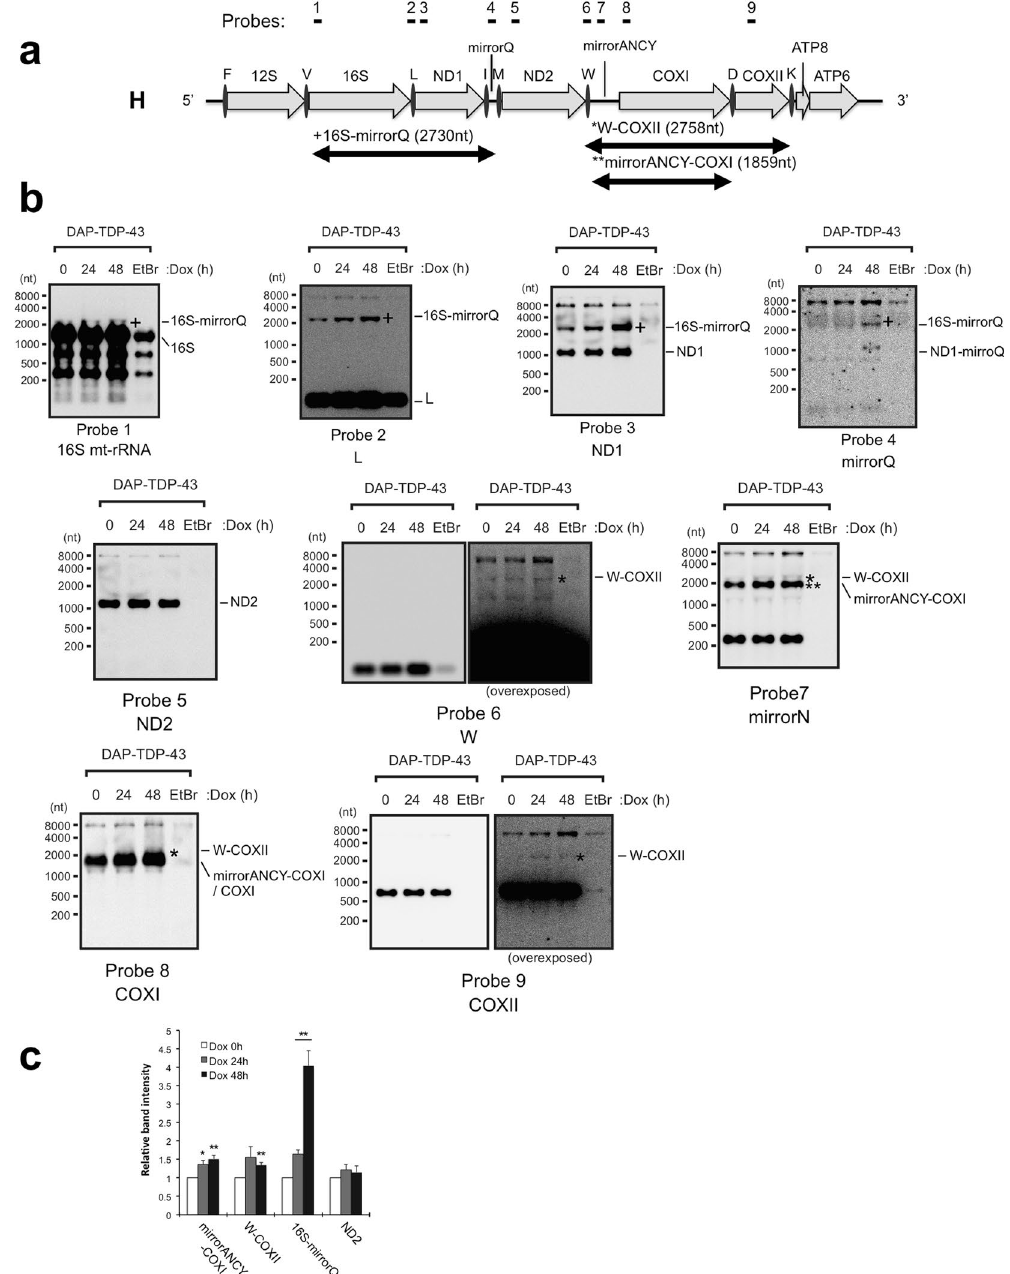
Figure 5. TDP-43 overexpression causes accumulation of intermediates of mitochondrial transcript. ( a ) Schematic diagram of H-strand mitochondrial DNA from mt-tRNA Phe (F) to ATP6, and the corresponding mt-transcripts are shown. Nine probes used for northern blotting are indicated above the diagram. ( b ) Total RNA extracted from DAP-TDP-43-expressing T-REx 293 cells harvested at 0, 24, or 48 h after doxycycline (Dox) induction were analysed by northern blotting with the probes indicated under the figures. EtBr served as a negative control for the mt-transcripts. The processing intermediates of mt-transcripts identified by northern blotting are indicated under the diagram and to the right of each panel. ( c ), Graphical representation of band intensities for the observed mt-transcripts shown in a relative to cells without Dox induction (0 h). Data are the average ± SEM of at least three independent experiments. ** P < 0.01; * P < 0.05 (paired t